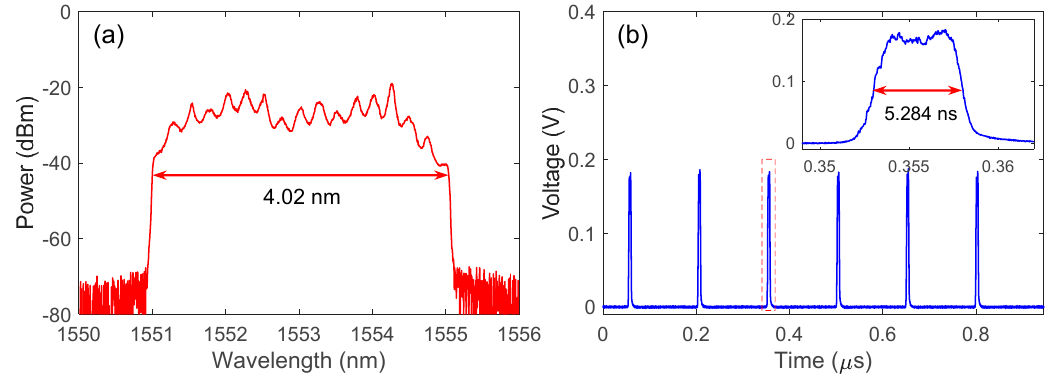
Figure 6. ( a ) The optical spectrum of the WSL; ( b ) the time domain signal of the WSL beating signal after the PD (the inset is the zoom-in of the pulse shape from 0.349 ns to 0.362 ns).